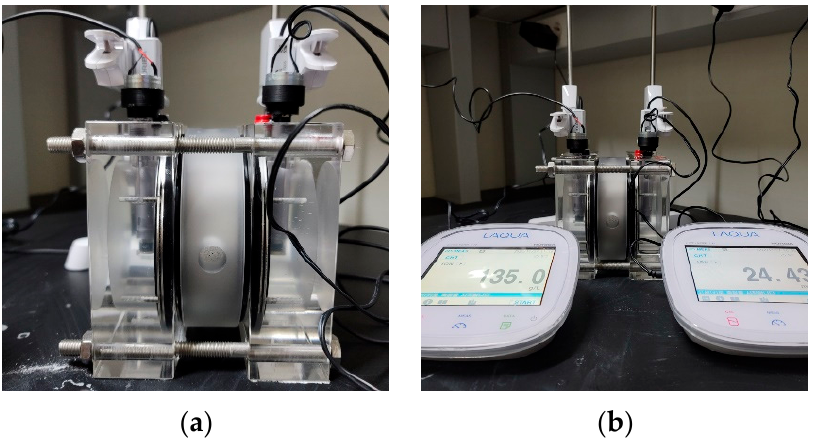
Figure 6. Photo for sulfate ion diffusion test: ( a ) setting image of test specimens; ( b ) setting image of ion meter for recoding the chaining sulfate ion concentration.